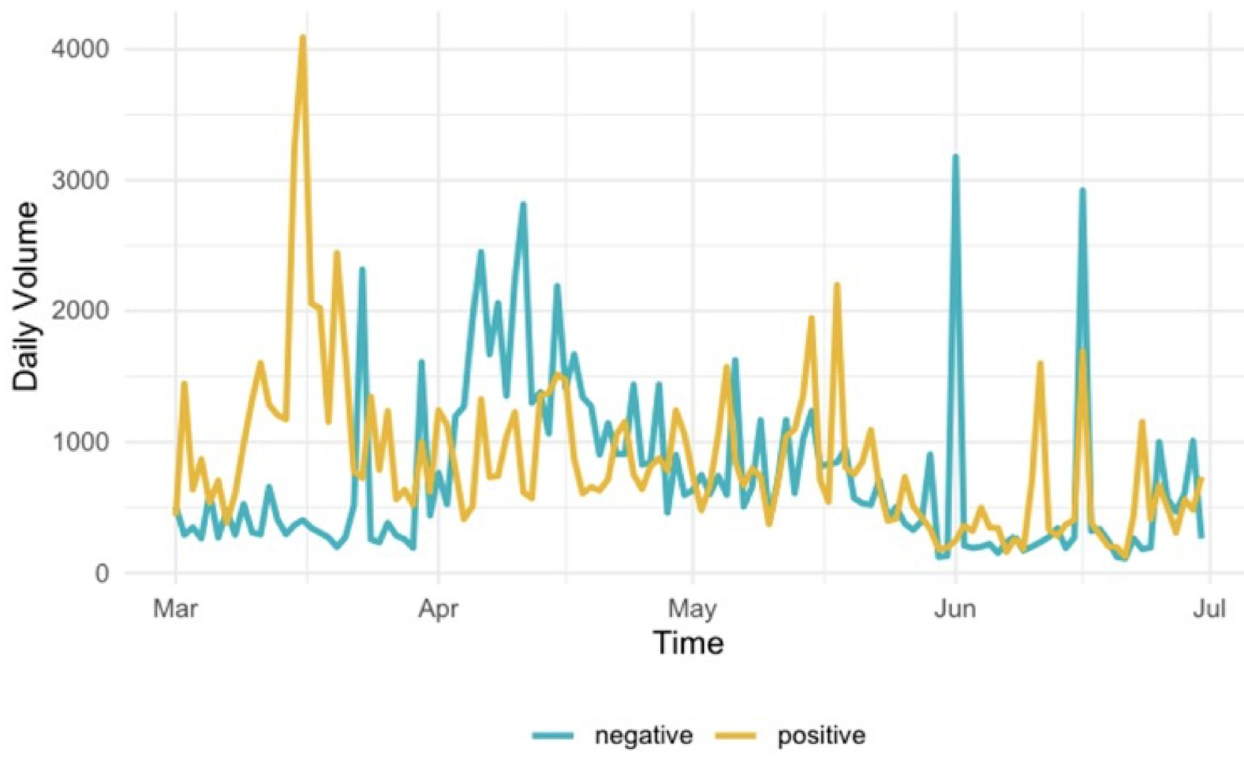
Fig 1. Twitter discourse volume over time.